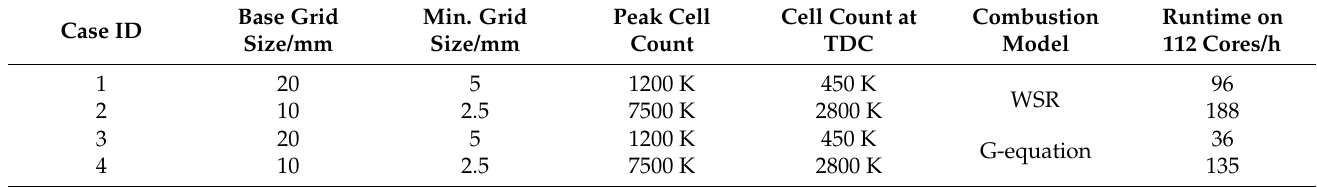
Table 5. Mesh details and simulation time cost under different grid size.